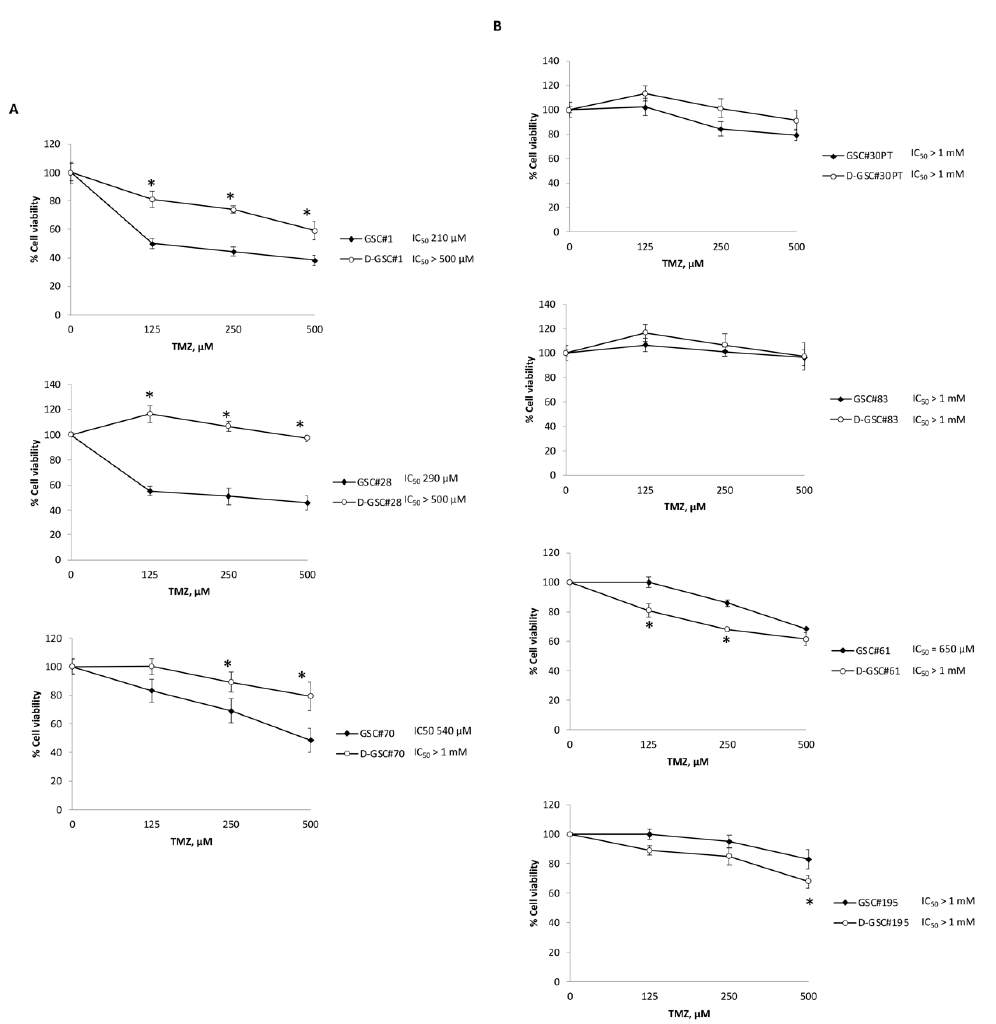
Figure 2. Effects of TMZ on growth of undifferentiated (GSC) and differentiated (D-GSC) cell lines. Cell growth was evaluated by 3-(4,5-dimethylthiazol-2-yl)-2,5-diphenyltetrazolium bromide (MTT) assay in TRPML2 negative GSC ( A ) and in TRPML2 positive GSC ( B ). Data shown are expressed as mean ± SE of three separate experiments. * p < 0.05 vs.